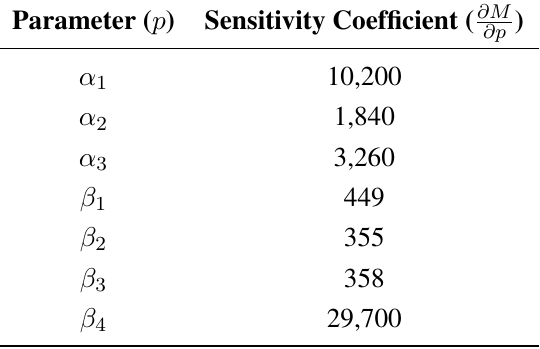
Table 2. Sensitivity in model output (steady-state level of M ) to changes in parameters by 5%. We see that the parameters with the greatest effect on output are β ± and α (the proliferative capacity of M 1